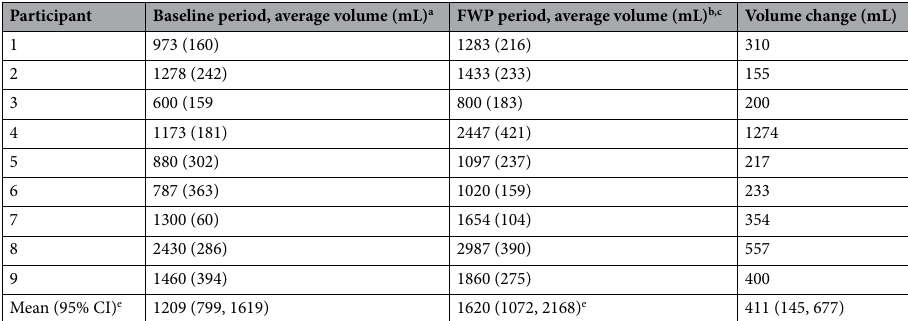
urine color, and oral hydration status (Table 4). At baseline, with a mean (95% CI LL, UL) BUN/Cr ratio of 27 (15, 38) mg/dL, only 33% (3/9) of participants had BUN/Cr ratios that were considered to be within-normal limits (i.e. within a range of 6–22 mg/dL) 32 . Following the FWP period, although 33% (3/9) of participants observed slight increases in their BUN/Cr ratio, indicating a slight worsening of their hydration, 78% (7/9) presented with BUN/Cr ratios considered to be within normal limits. Despite this moderate improvement, the